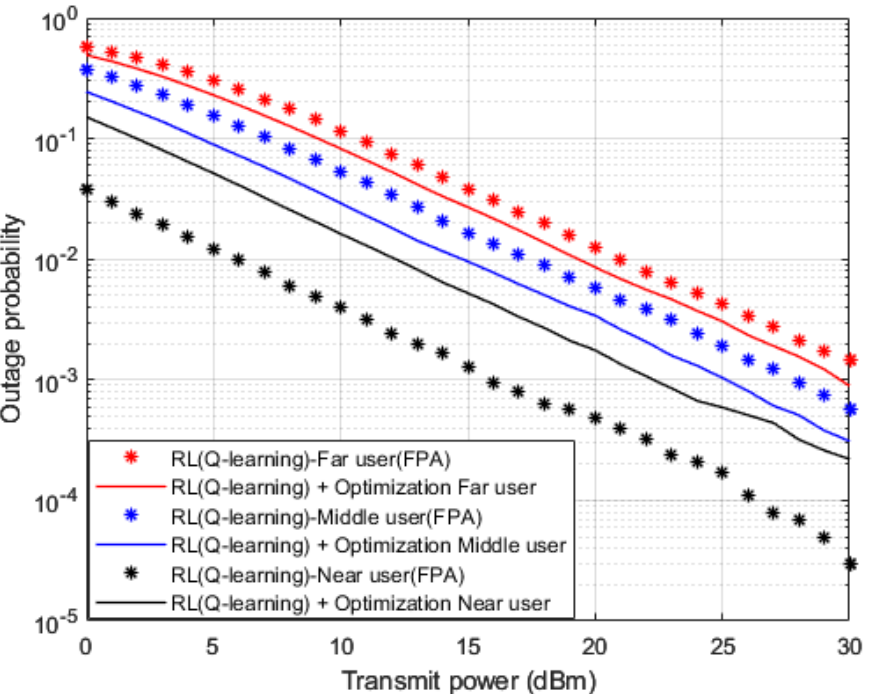
Figure 14. Outage Prob. vs. Power ( Q ‐ learning, Optimization, FPA).